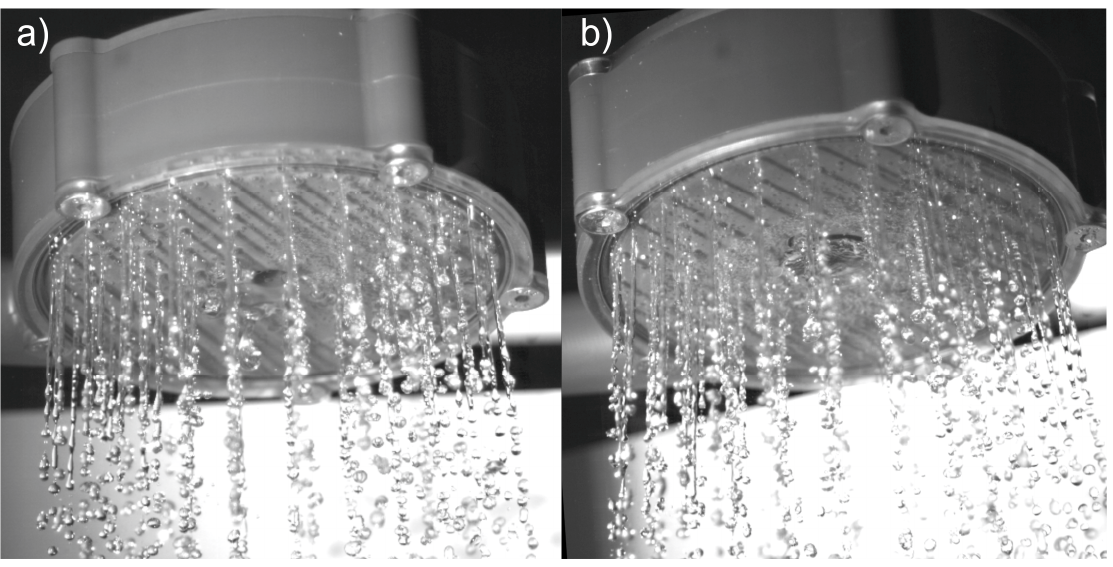
Figure 3. High-speed photography of the regular ( a ) and vortex ( b ) showerhead.